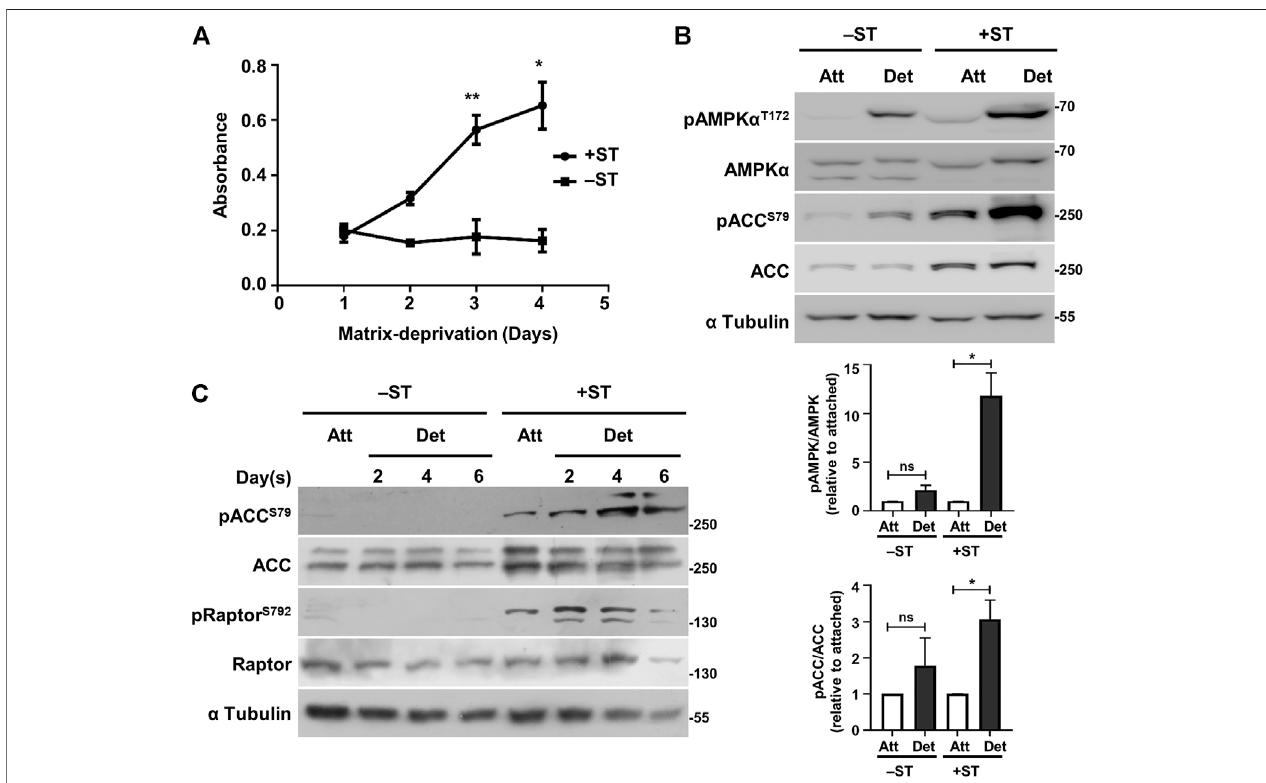
FIGURE 1 | +ST cells display increased survival and sustained AMPK activity under matrix-deprived conditions as compared to − ST cells: (A) − ST and +ST cells grown in a 96-well ultra-low attachment plate that prevents cell-attachment were subjected to MTT assay at speci fi ed time periods. Absorbance of formazan crystals dissolved in DMSO was monitored for 4 days; n (cid:1) 4. Error bars represent mean ± SEM. (B) − ST and +ST cells subjected to conditions of attachment (Att) and matrix- deprivation(Det)for24 h,wereharvestedforimmunoblotanalysesforthespeci fi edproteins.Graphsrepresentdensitometricquanti fi cationofphospho-proteinsto total proteinsnormalizedto α -tubulin andrelative totheattached conditionforeachcellline;errorbars represent mean ± SEM; n (cid:1) 3. (C) − STand +STcellssubjectedto matrix-deprivation(Det)for2,4and6 dayswereharvestedforimmunoblotanalysesforthespeci fi edproteins.Adherent/attachedcells(Att)wereusedascontrols; n (cid:1) 3.